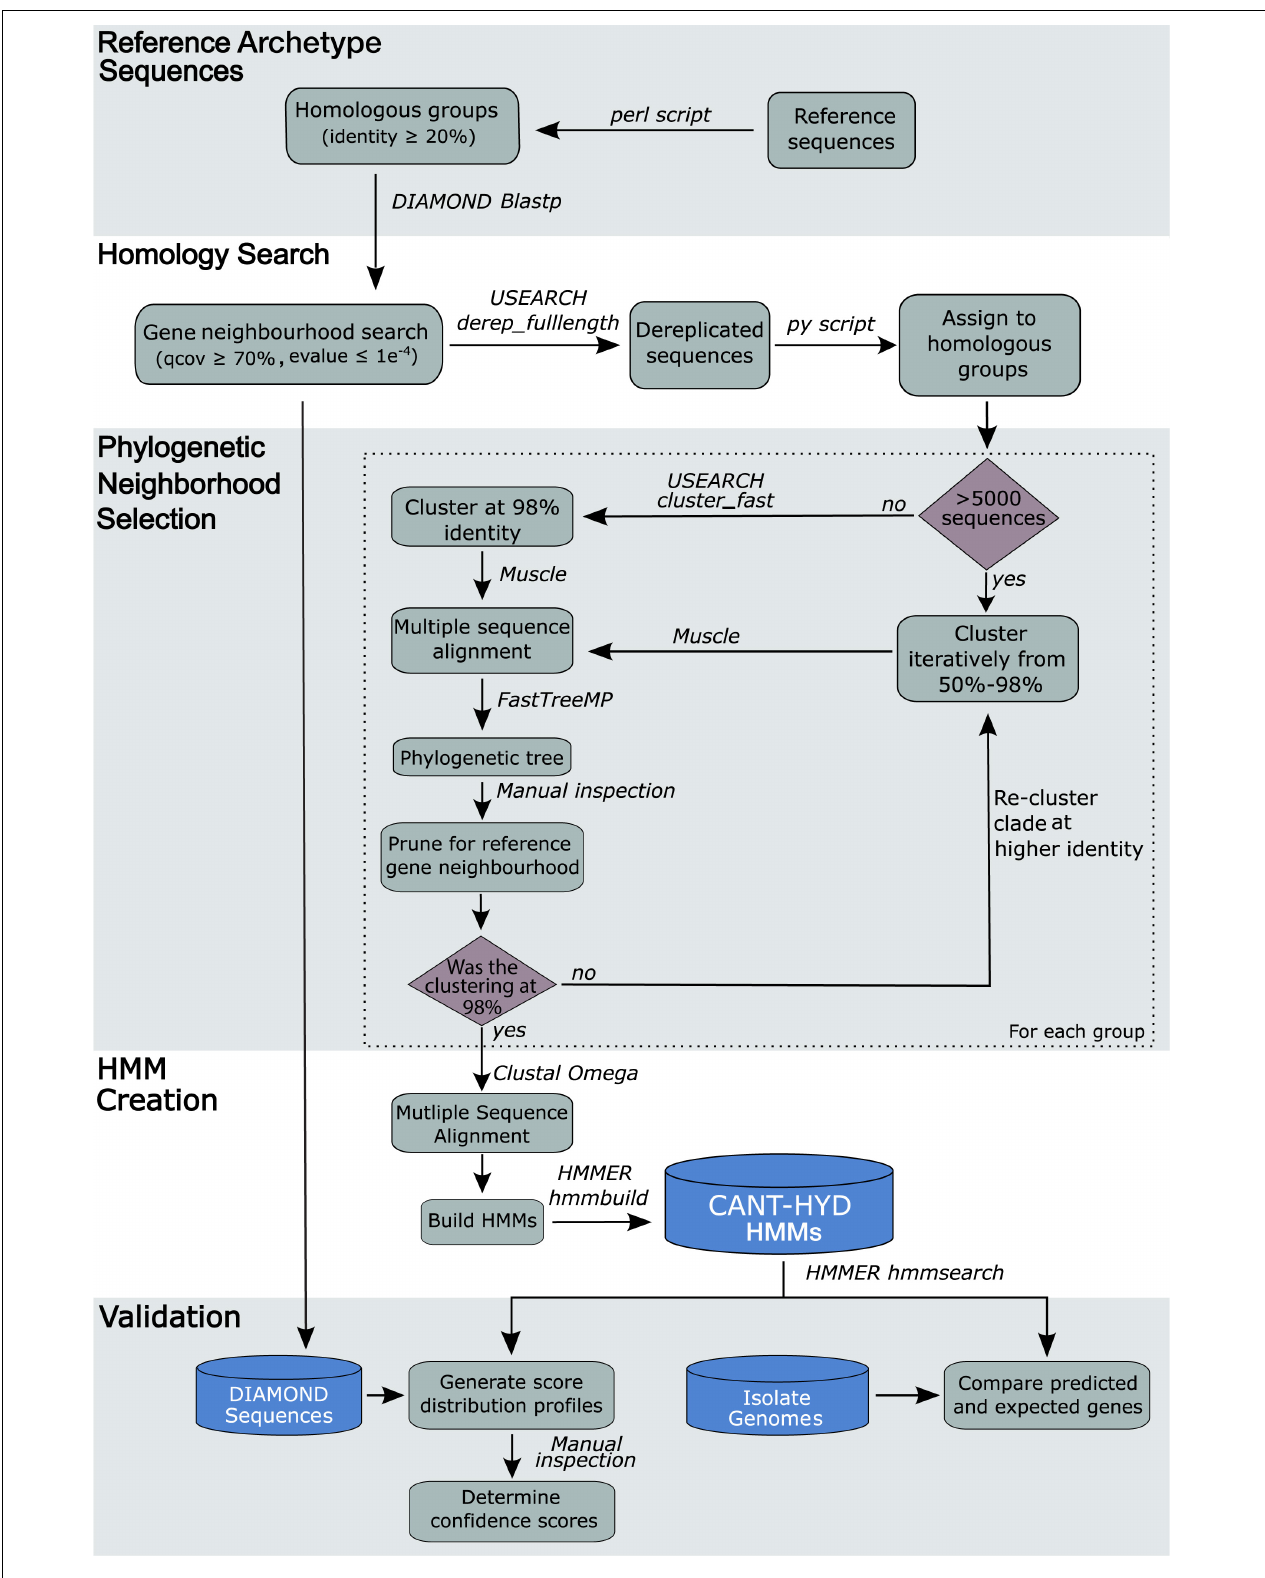
FIGURE 2 | Workflow of the process underlying the creation of the CANT-HYD HMM Database.